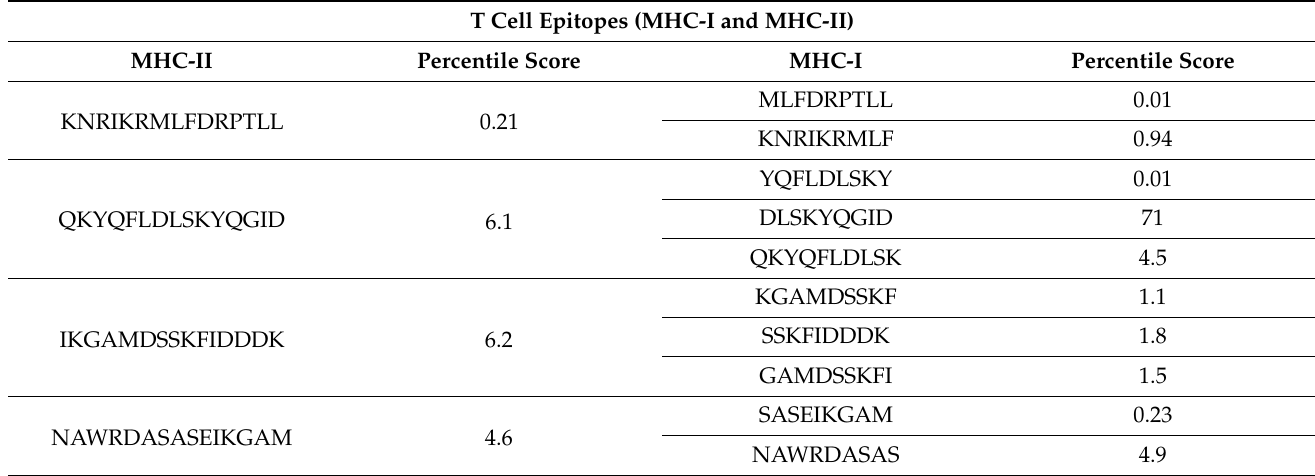
Table 6. Predicted MHC-I and MHC-II epitopes (T cell epitopes) based on percentile rank. T Cell Epitopes (MHC-I and